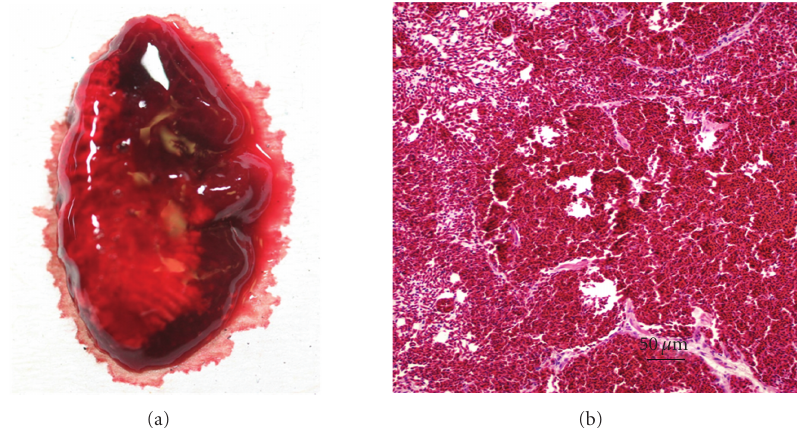
Figure 2: Toxicity of Nandina domestica in Cedar Waxwings. (a). Photograph showing pulmonary edema, congestion and hemorrhage. (b). Photomicrograph showing di ff use severe pulmonary congestion and hemorrhage. H&E stain. Bar: 50 μ